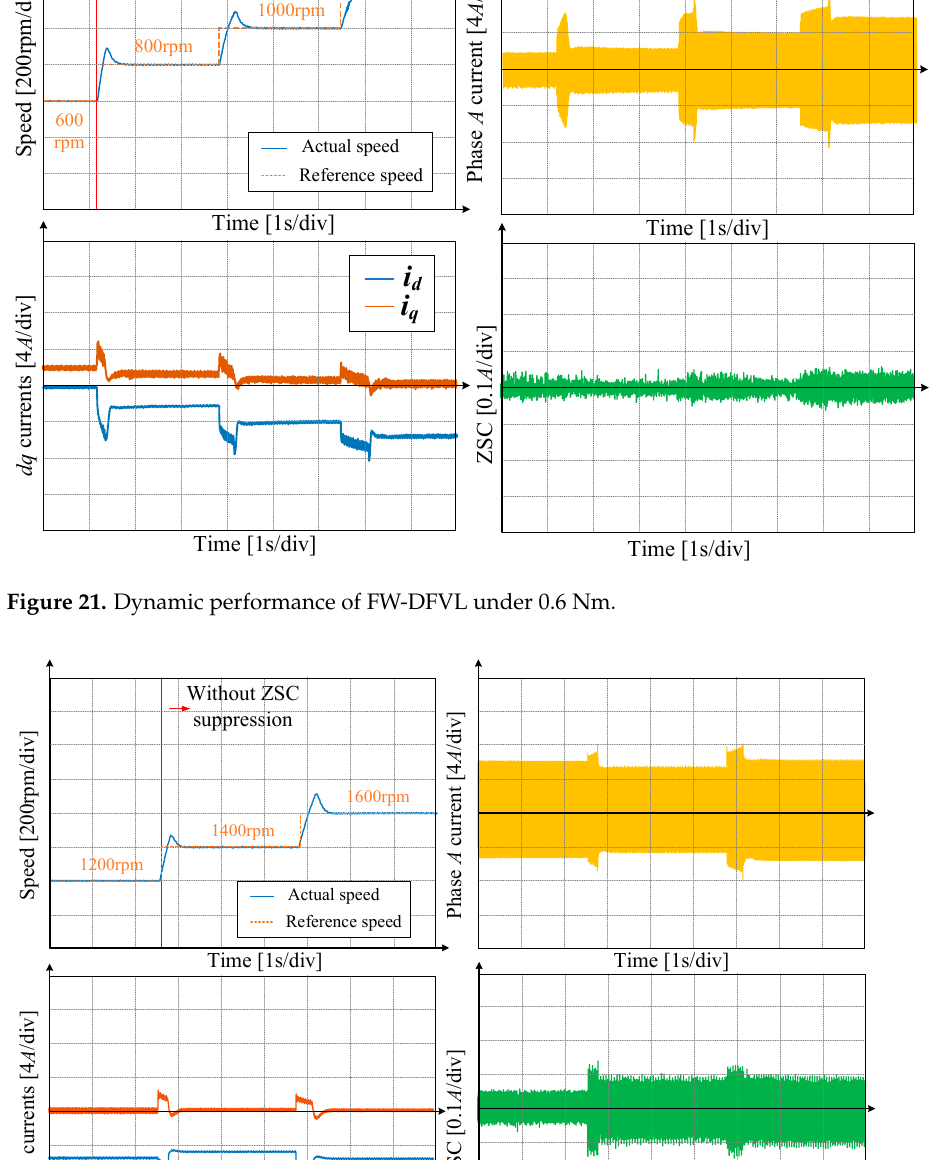
Figure 20. Dynamic performance of FW-DFVL under no load.